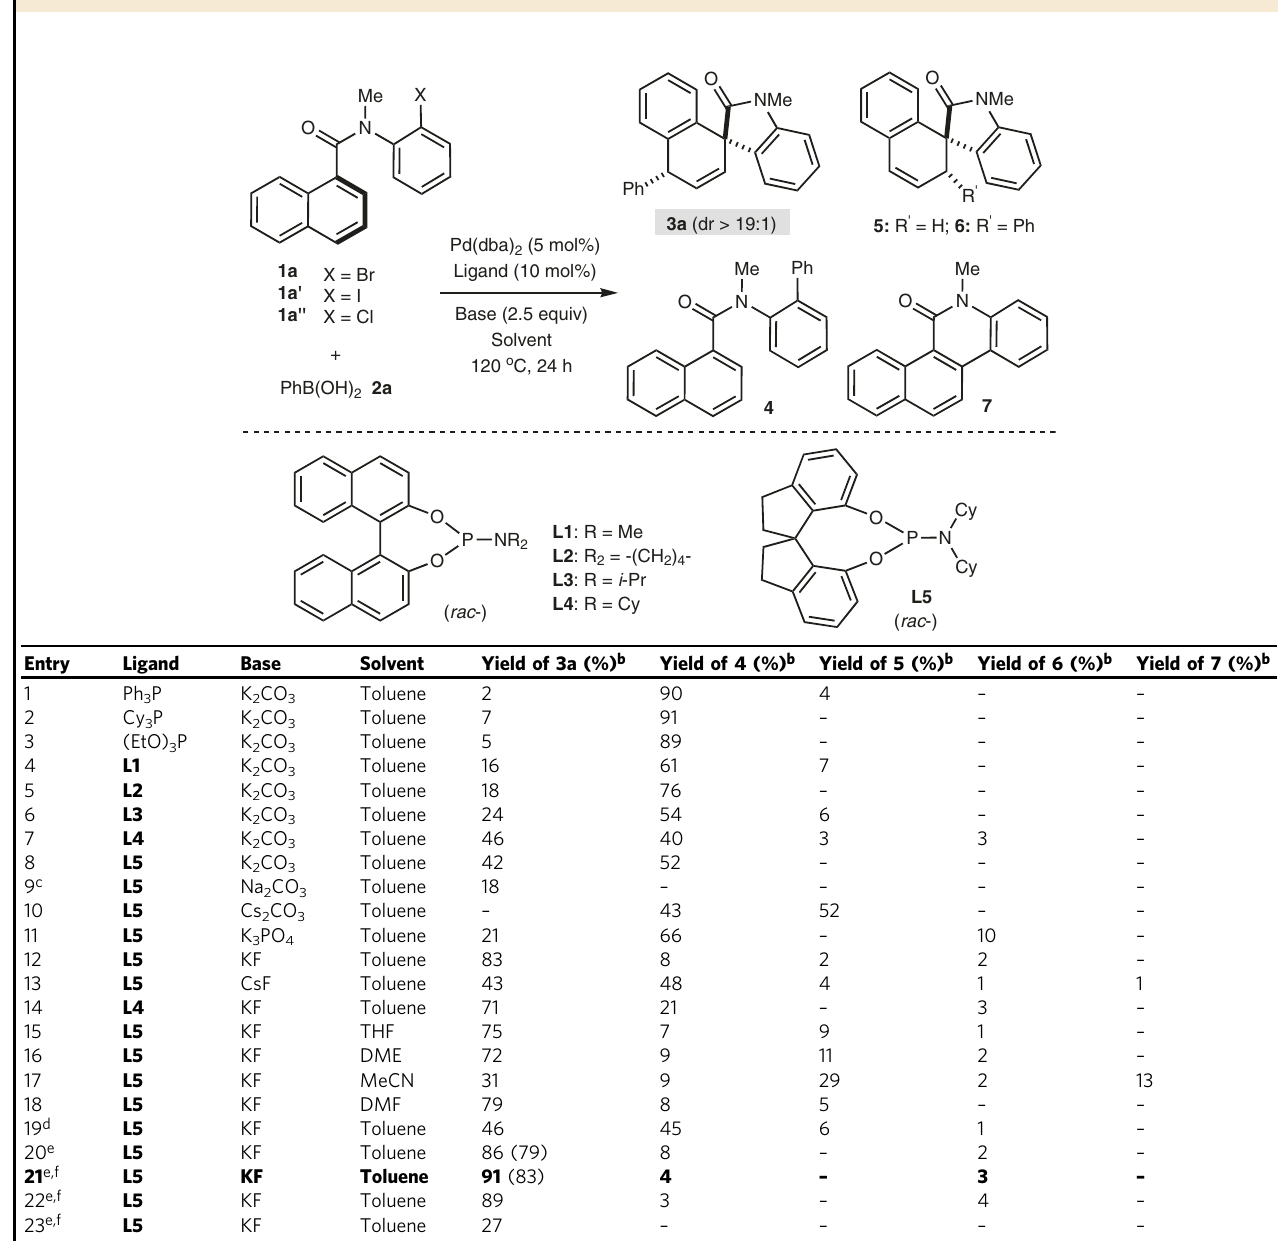
Table 1 Reaction optimization a